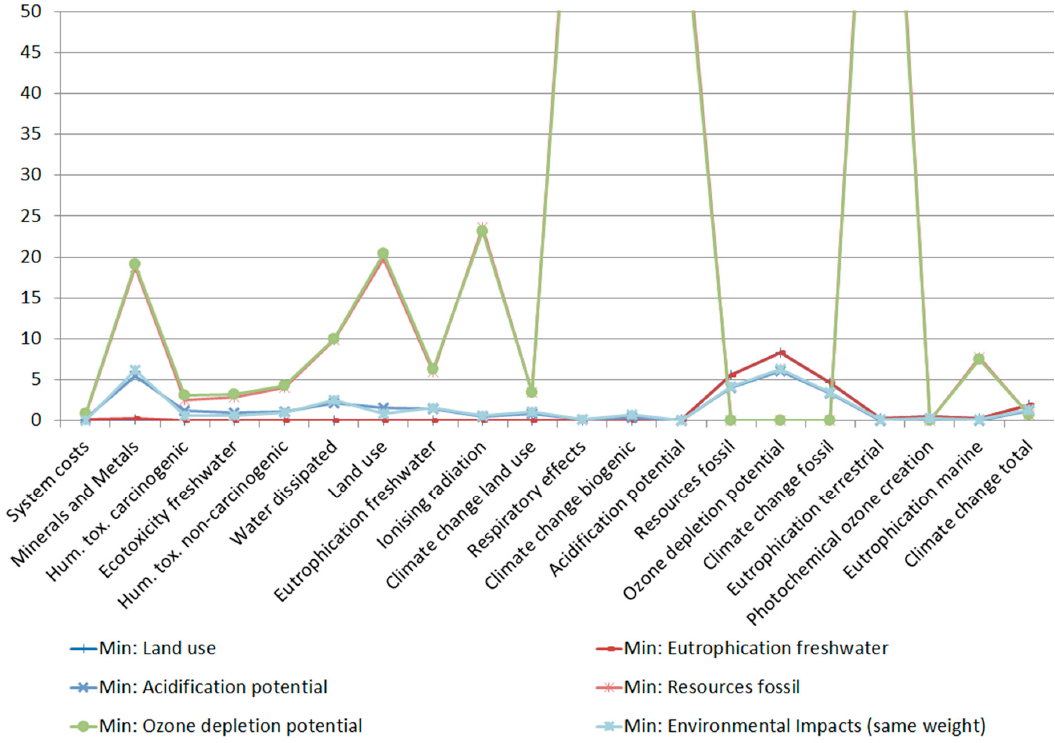
Figure 5. Normalised distances from optimum for the individual criterion of selected objective functions (selection of optimisation runs with the two highest (min: Ozone depletion potential, min: Eutrophication freshwater, lowest (min: Acidification potential, min: Environmental Impacts (same weight) and medium (min: Land use, min: Eutrophication freshwater) standard deviations of normalised distances of all indicators).